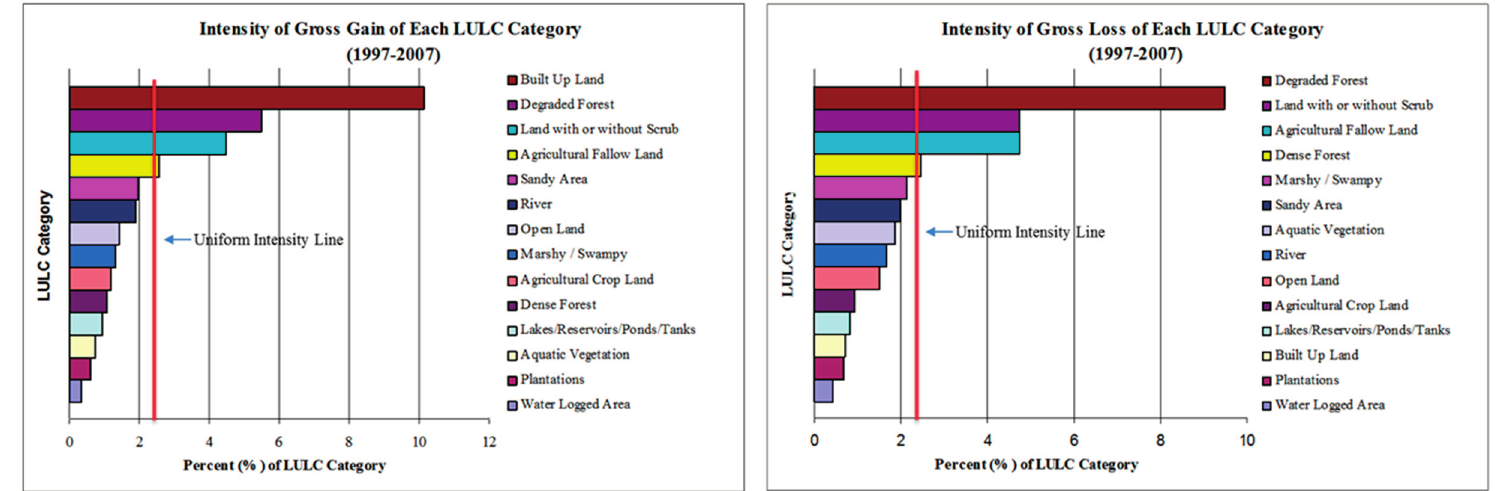
Figure 7. Intensity of gross gain and gross loss of each LULC category in between 1987 and 1997.